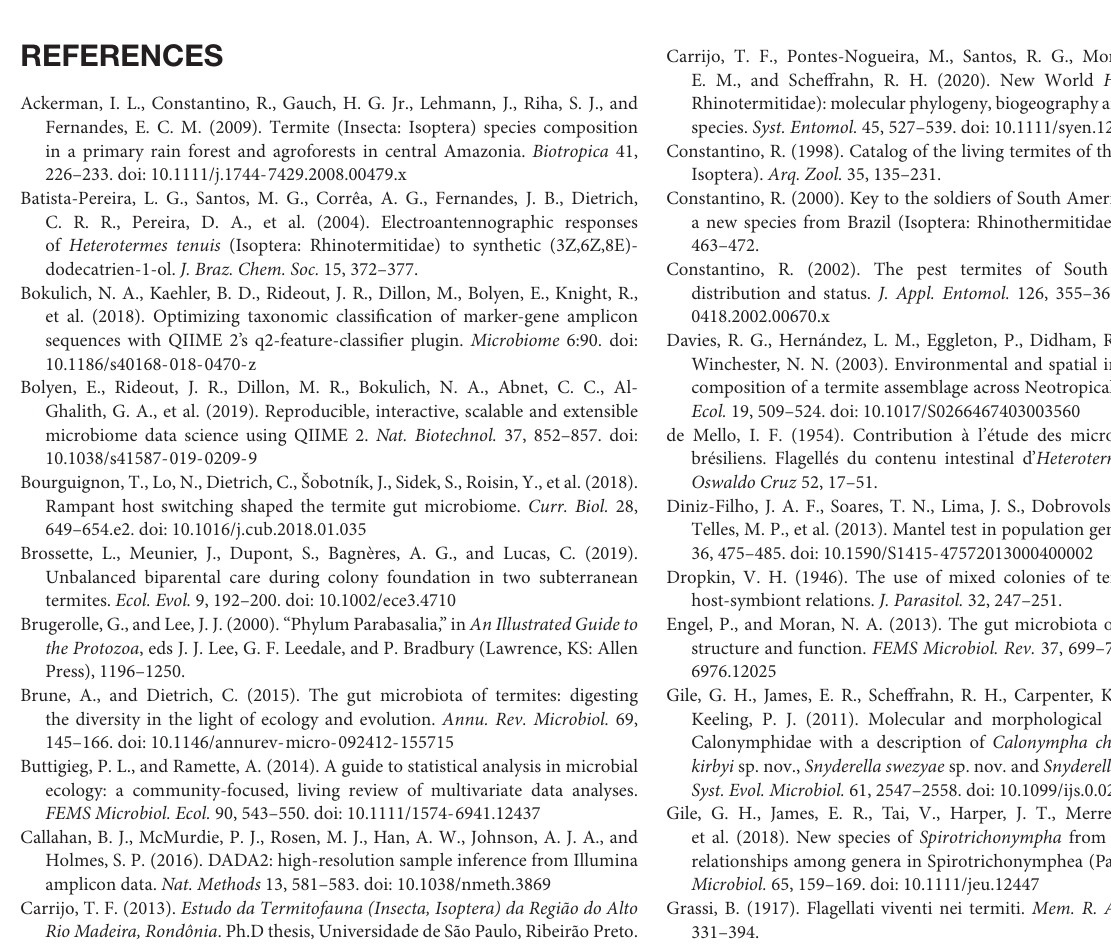
Supplementary Figure 3 | Unrooted maximum likelihood phylogenetic tree of Cthulhu 18S rRNA gene sequences from isolated cells and from amplicon profiling of termite gut contents. Isolated cell sequences determined in this study are nearly full length ( ∼ 1500 bp) and are indicated by red font. ASV sequences from amplicon profiling comprise only the V4–V5 regions of the 18S rRNA gene ( ∼ 450 bp) and are indicated by qiime2-generated sequence IDs in black text. Supplementary Figure 4 | Unrooted maximum likelihood phylogenetic tree of Pseudotrichonympha 18S rRNA gene sequences from isolated cells and from amplicon profiling of termite gut contents. Nodes are intentionally compressed to show backbone structure. Isolated cell sequences determined in this study are nearly full length ( ∼ 1500 bp) and are indicated by red font. ASV sequences from amplicon profiling comprise only the V4–V5 regions of the 18S rRNA gene ( ∼ 450 bp) and are indicated by qiime2-generated sequence IDs in black text. Supplementary Table 1 | Termite collection data, number of individuals assayed per collection, and protist taxonomy assignment of 18S rRNA ASV reads. Supplementary Table 2 | Isolated cell codes, localities, length measurements, and number of clones sequenced. Supplementary Table 3 | Diversity and distribution metrics of ASVs for each protist phylotype. Supplementary Table 4 | Protist phylotype prevalence across